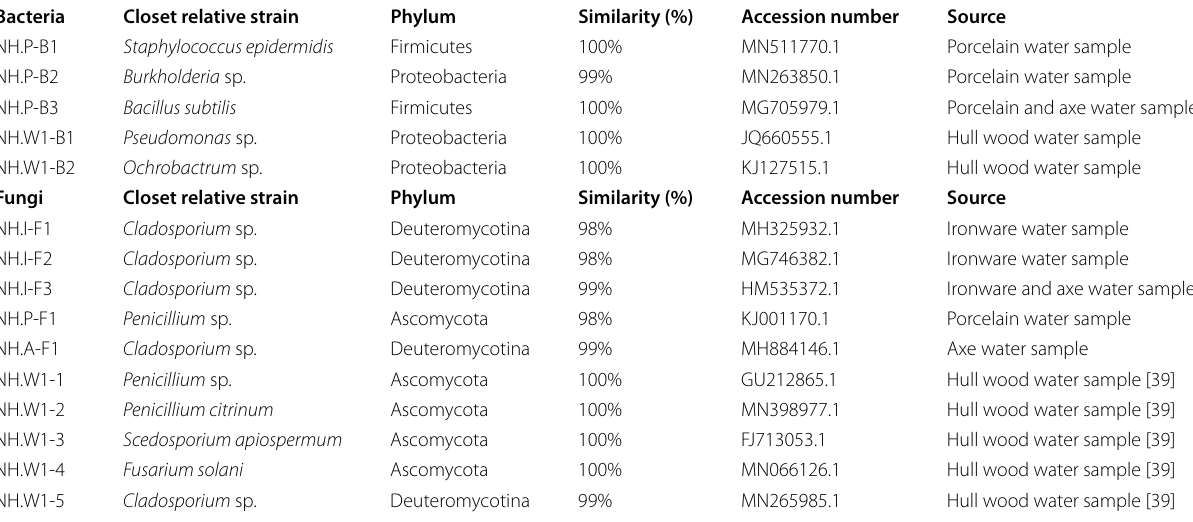
Table 2 Molecular identification of culturable strains isolated from four kinds of water samples Bacteria Closet relative